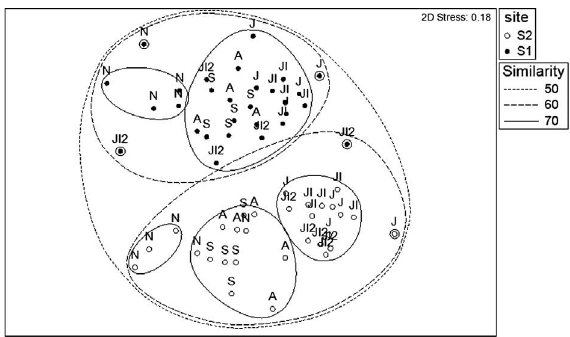
Fig . 5. – MDS plot based on crustacean species abundance at S1 and S2 (J, June; Jl, first cruise of July; Jl2, second cruise of July; A, August; S, September; N, November). Lines define groups with 50%, 60% and 70% Bray-Curtis similarity.